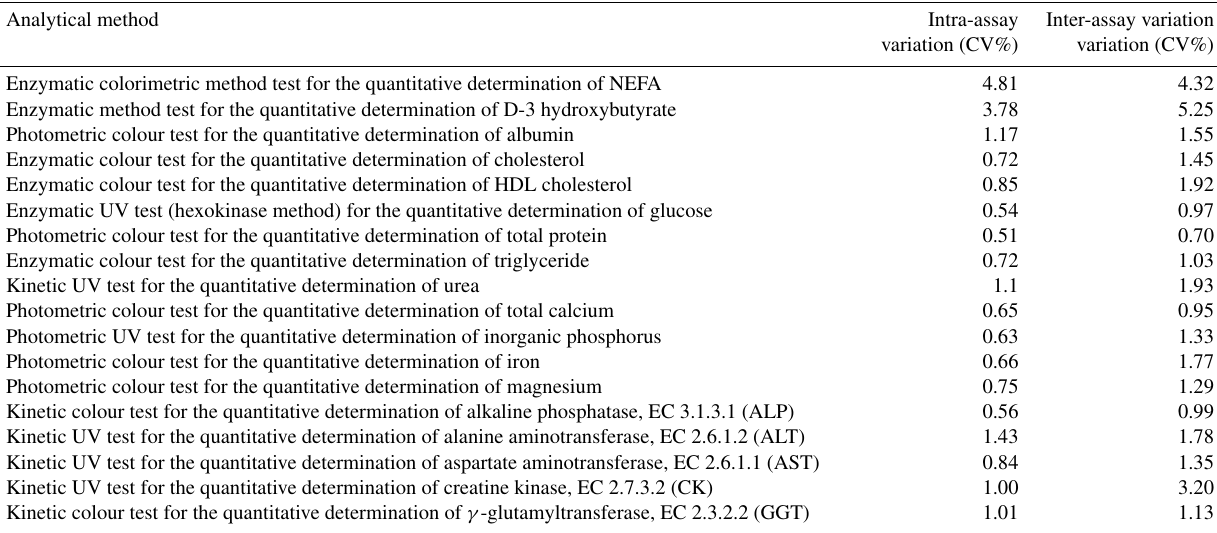
Table 2. Analytical methods for blood parameters and quality laboratory